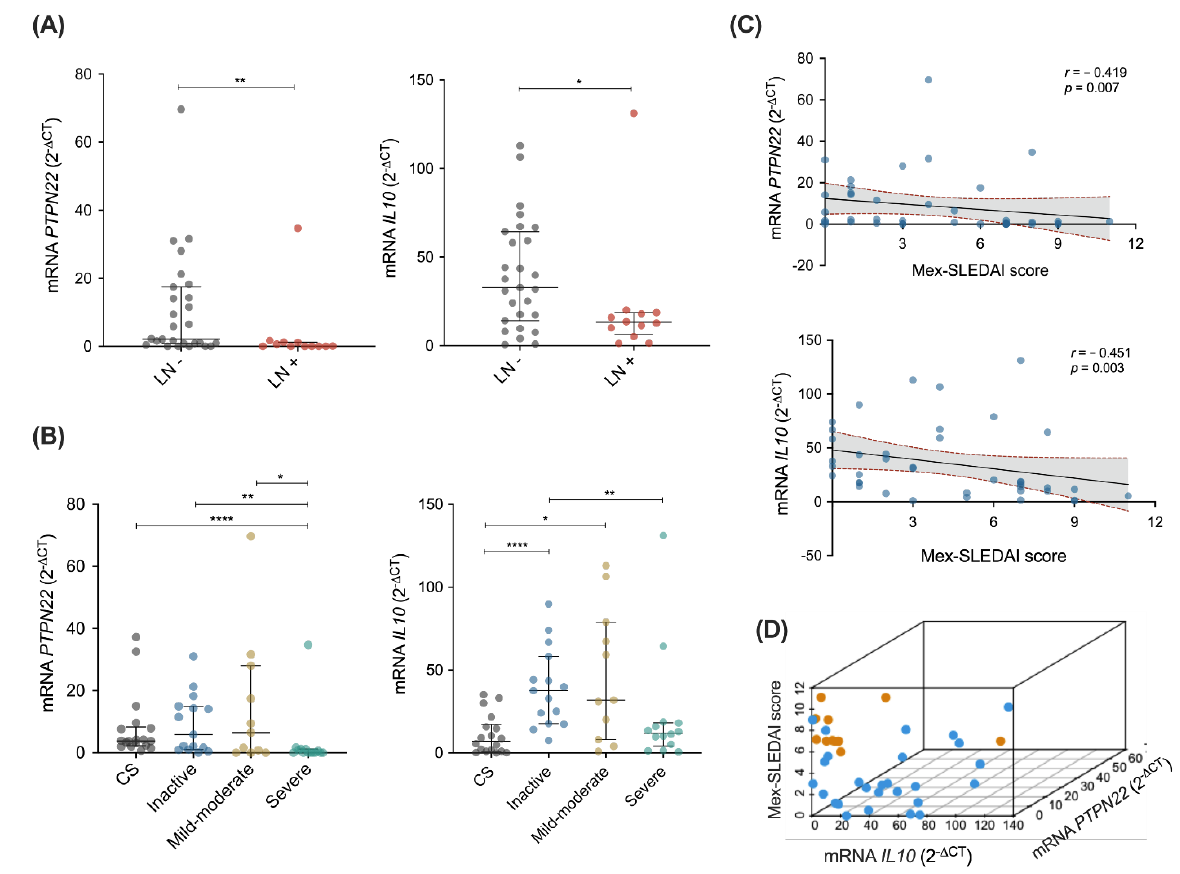
Figure 2. PTPN22 and IL10 gene expression in association with renal involvement and disease activity in SLE patients. ( A ) PTPN22 and IL10 mRNA in SLE patients without renal damage (LN-, n = 27) vs. patients with renal damage (LN+, n = 12), data are presented in median (p25–p75); ( B ) PTPN22 and IL10 mRNA according to Mex-SLEDAI disease activity groups: 0–2 inactive ( n = 15), 3–5 mild-moderate ( n = 11), and ≥ 6 severe ( n = 14), data are presented in median (p25–p75); ( C ) correlation between PTPN22 (top panel) and IL10 (bottom panel) mRNA with Mex-SLEDAI score; ( D ) 3D plot showing Mex-SLEDAI score (y axis), IL10 mRNA (x axis), and PTPN22 mRNA (z axis) in SLE patients with renal damage (orange) and without renal damage (blue). Differences between groups were determined using the Mann–Whitney U test. Linear correlation coefficients were determined using Spearman’s correlation test. LN: lupus nephritis, CS: control subjects. * p < 0.05, ** p < 0.01, **** p < 0.0001.